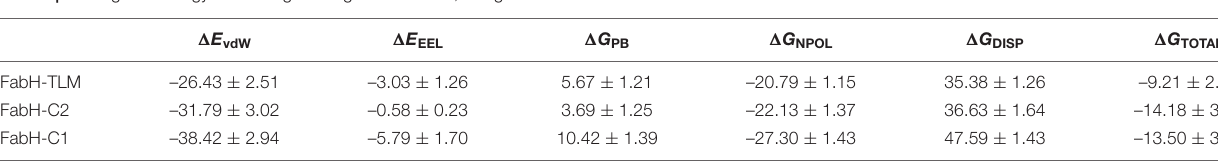
FIGURE 13 | A comparative principal component analysis plots of mtFabH and mtFabH docked complexes with TLM and compounds C1 and C2. TABLE 4 | Binding free energy of three ligands against mtFabH, using